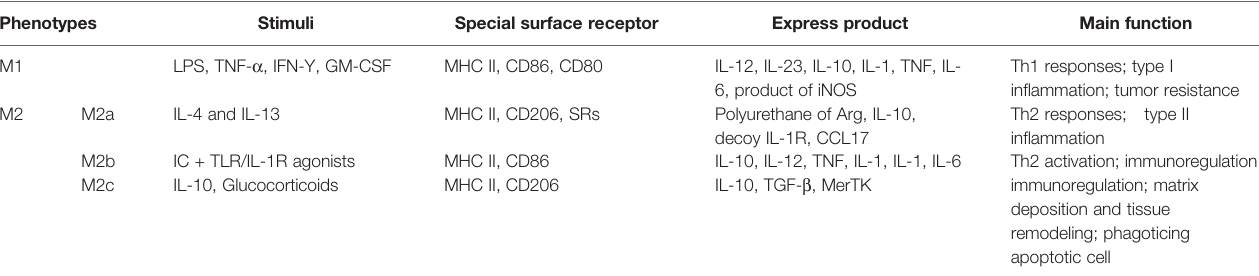
TABLE 1 | The polarization types, characteristics and basic functions of